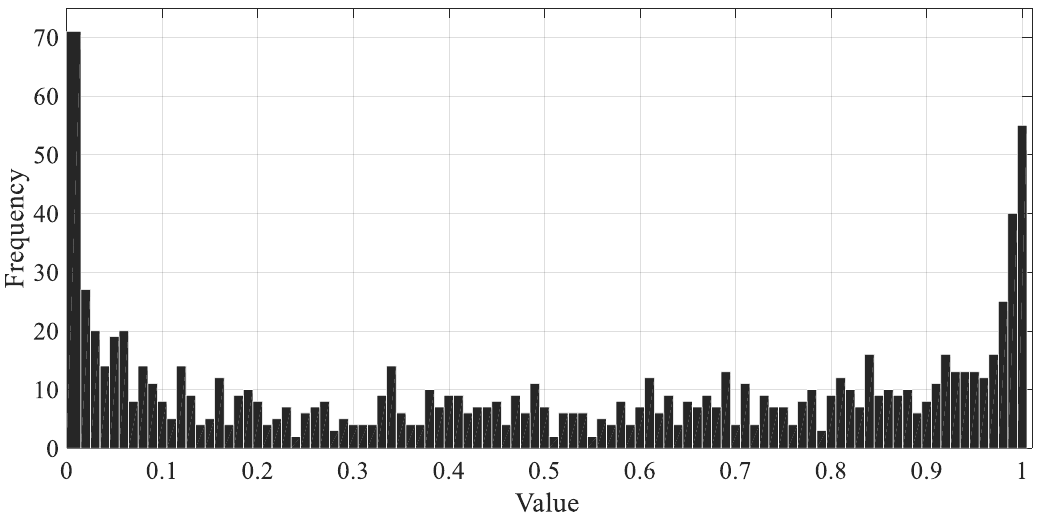
Figure 2. Generated weights ( ρ Chebyshev ) from a Chebyshev chaotic map over 1000 iterations.